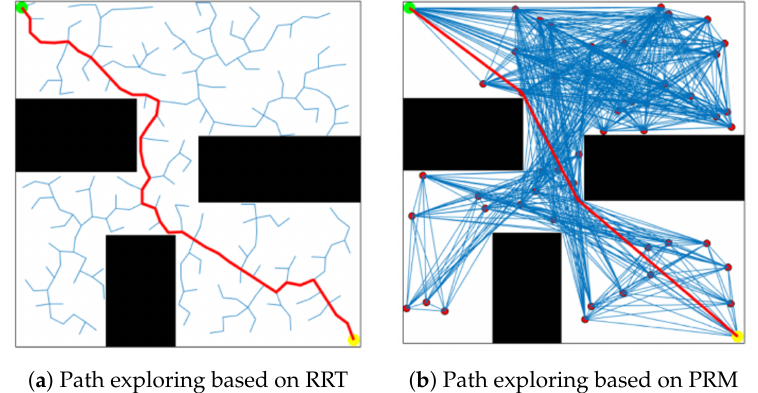
Figure 5. Graph search algorithm based on